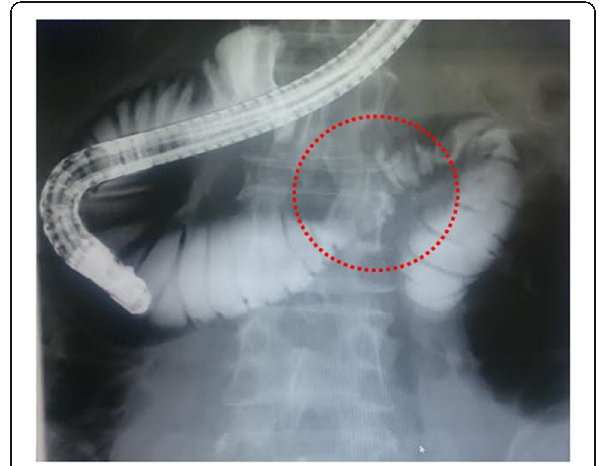
Fig. 4 Duodenography, added to ERCP, showed a slight narrowing (red circle) of the third portion and dilatation of the oral side; however, air sent from the endoscope could pass through the narrowed area. Clinically, the patient did not complain of gastrointestinal obstruction before